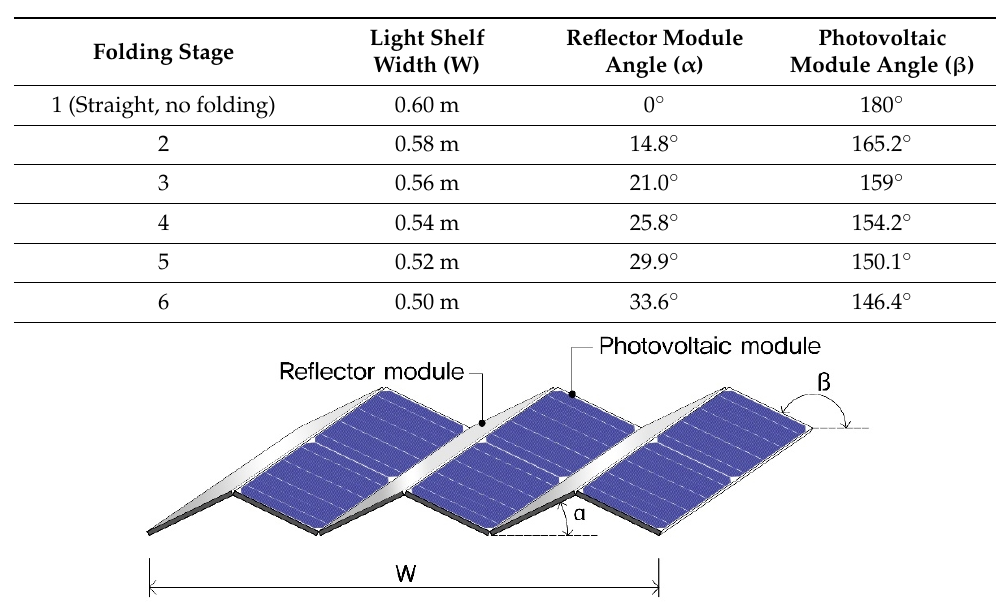
Table 4. Folding shape, light shelf angle, and photovoltaic module angle according to the width of Case 3.